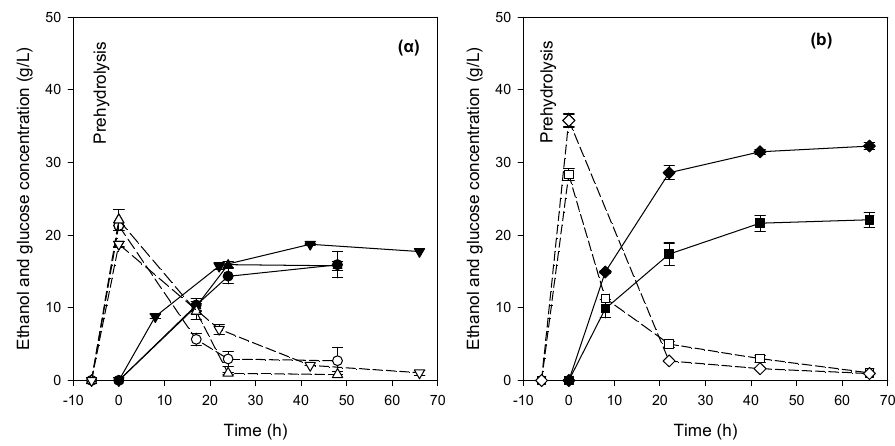
Figure 1. Bioethanol production from pretreated CS at 15% ( w / v ) substrate concentration after 6 h pre-hydrolysis. ( a ) Microwave-assisted acid pretreatment ( ) ethanol and ( ) glucose; alkali pre-treatment ( ) ethanol and ( ) glucose; hydrothermolysis ( ) ethanol and ( ) glucose; ( b ) organosolv ( ) ethanol and ( ) glucose; combined organosolv-hydrothermolysis ( ) ethanol and ( ) glucose.